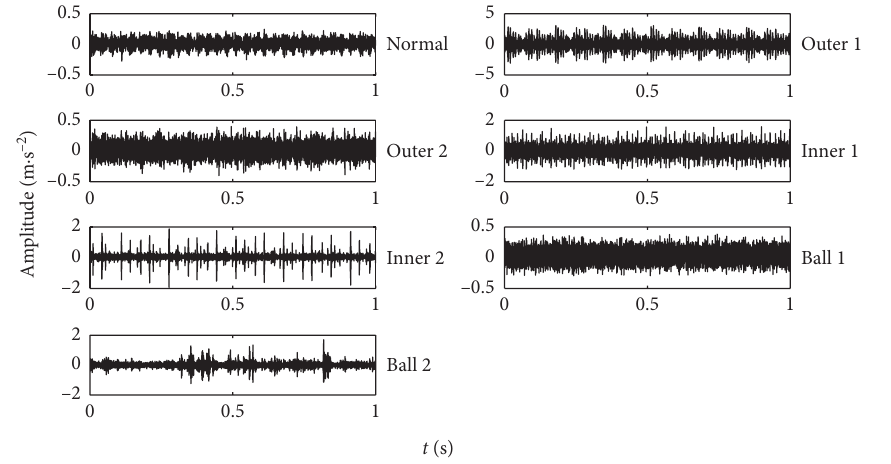
Figure 8: Time-domain diagram of each state signal.